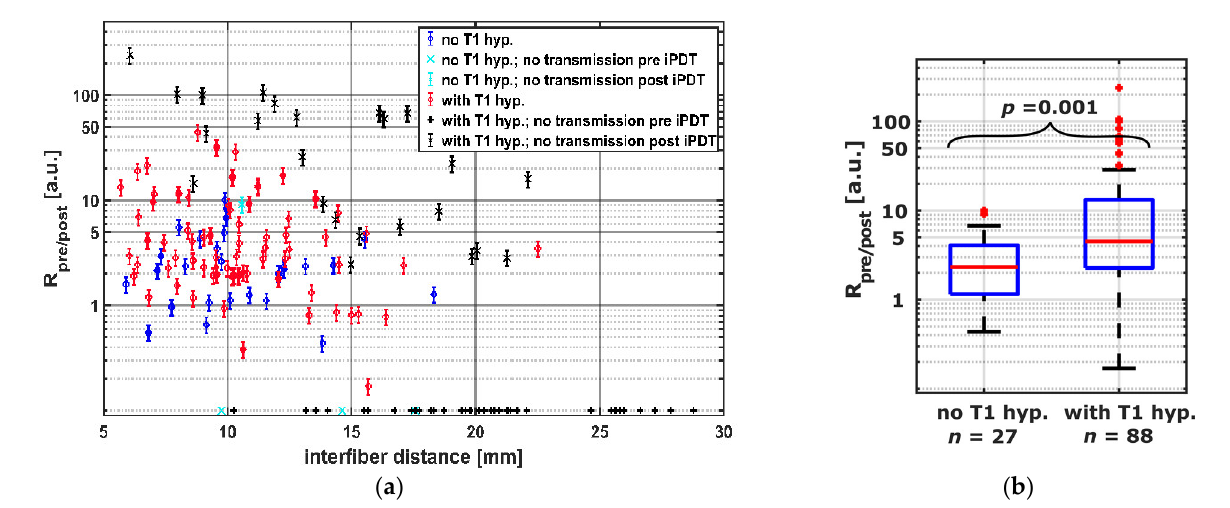
Figure 5. ( a ) Transmission ratios R pre/post for all CDF-pairs compared to interfiber distance. The colors and symbols indicate whether transmission was detectable post iPDT and whether T1 hyperintensity was observed (see legend). Crosses near the x-axis indicate CDF-pairs with no detectable treatment light transmission at iPDT start, for which R pre/post is defined as 0. ( b ) Comparison of CDF-pairs with and without local intrinsic T1 hyperintensity, considering only CDF-pairs with detectable transmission pre iPDT and interfiber distance ≤ 19 mm.